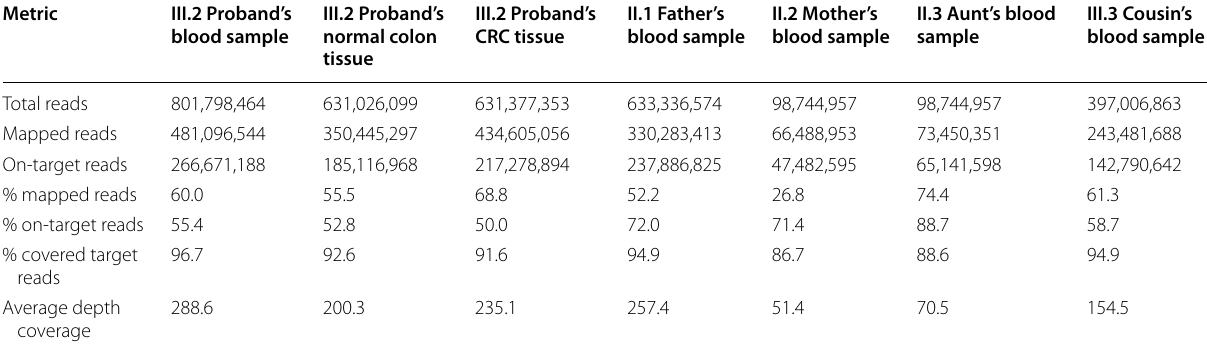
Table 2 Metrics of whole-exome sequencing (WES) analysis of the specimens from the proband and his relatives entering into the present study